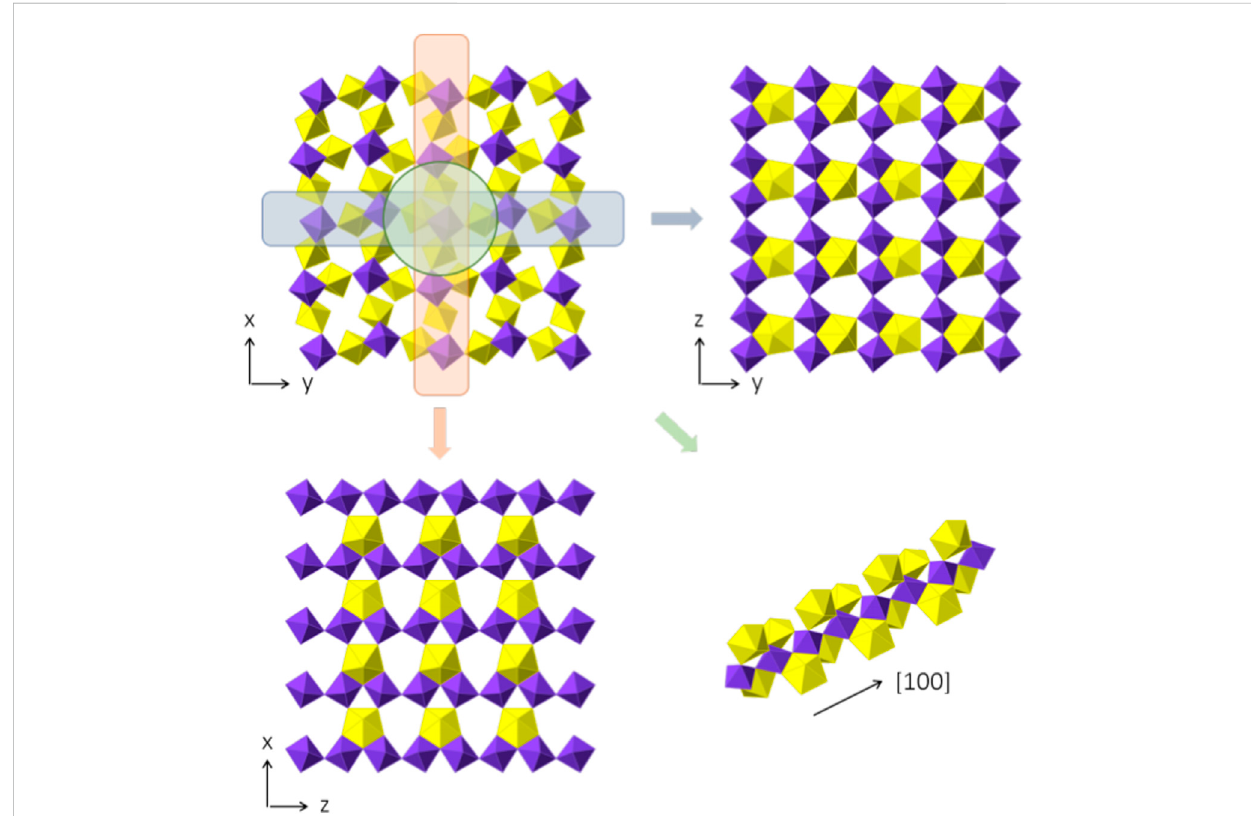
FIGURE 7 FrameworkcompositionofSr[(UO 2 )(TeO 5 )].Inthetop-left,thecompletestructure,omittingtheSrpositionsforclarity,whicharepositionedwithin the empty voids, is shown, perpendicular to [001]. Two-dimensional slices of the (100) and (010) plane are shown on the top right and the lower left. The layers are basically identical, despite the orientation. In the lower right, the in fi nite chain of [TeO 5 ] 4 − polyhedra is shown with the corner and edge sharing with UO 7 pentagonal bipyramids.